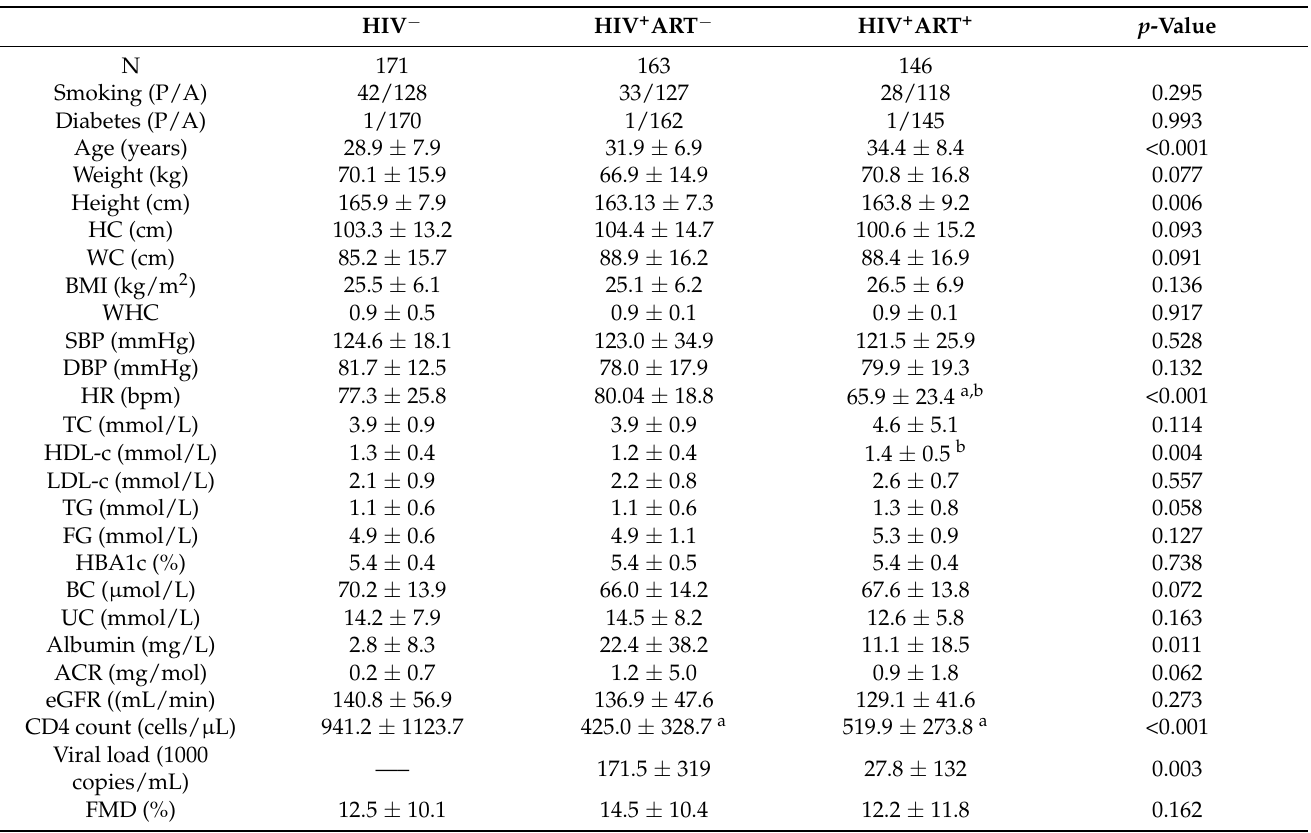
Table 1. Baseline characteristics of study population.